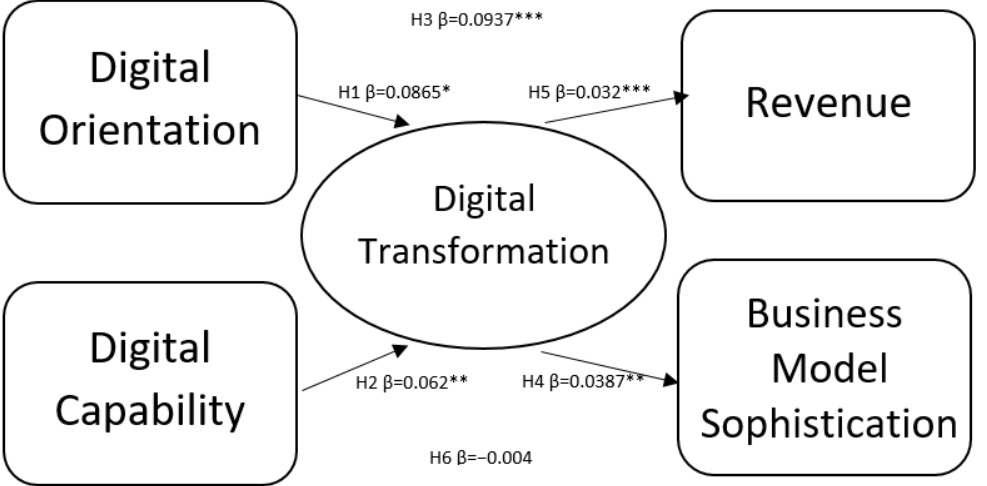
Figure 2. Structural model. Notes: * significant at p ≤ 0.1, ** significant at p ≤ 0.05, *** significant at p ≤ 0.01.